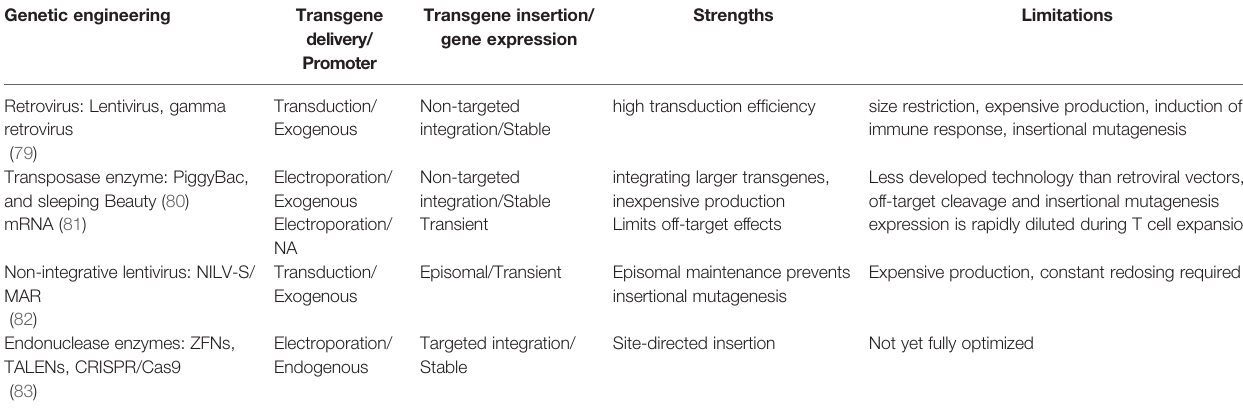
TABLE 1 | Current ex vivo genetic engineering strategies for CAR expression.